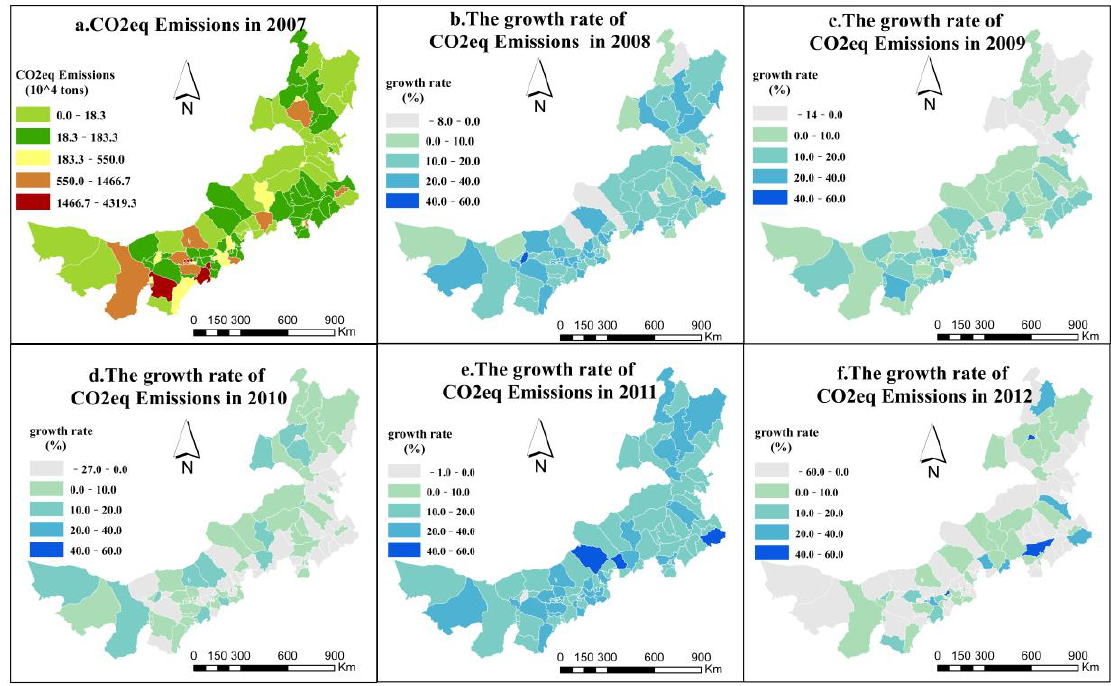
Figure 2. The spatiotemporal distribution of CO 2eq emissions and the annual growth rate in the counties of Inner Mongolia from 2007 to 2012. (Subfigure a representsCO 2eq emissions in 2007 and subfigure b – f represent growth rate of CO 2eq emissions compared to last year respectively. This type of visualization can show the temporal and spatial changes of CO 2eq emissions).